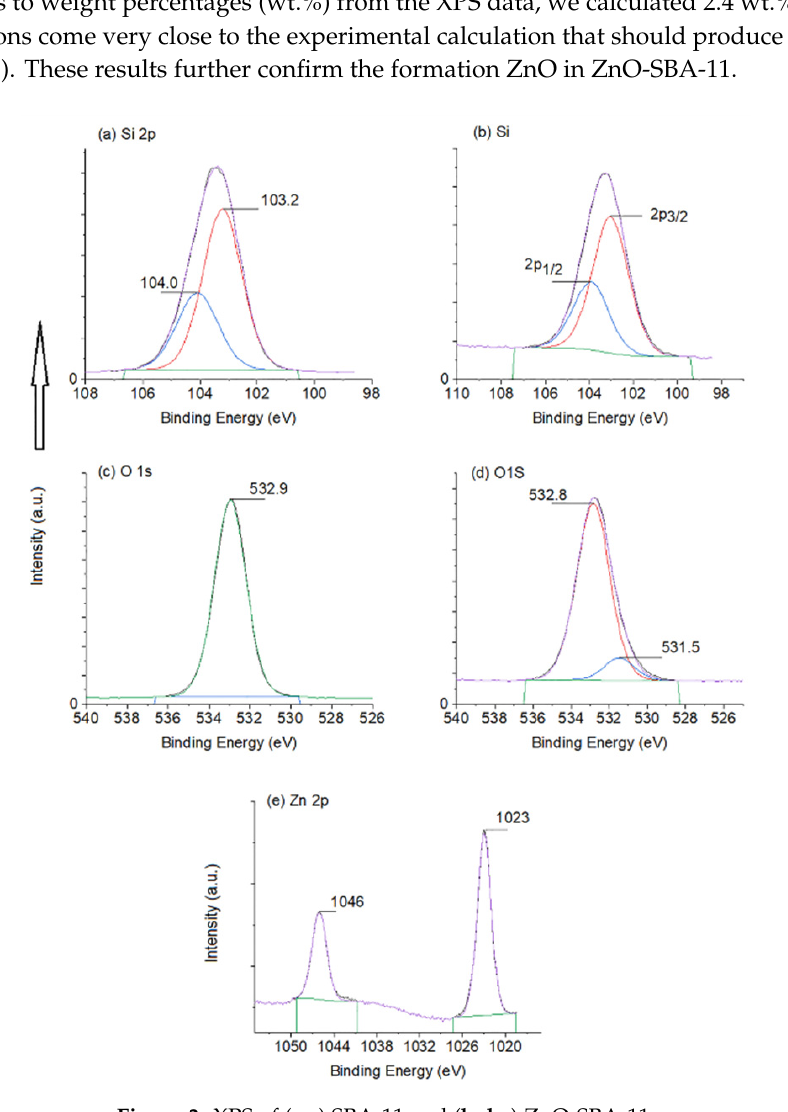
Figure 3. XPS of ( a , c ) SBA-11 and ( b , d , e ) ZnO-SBA-11.